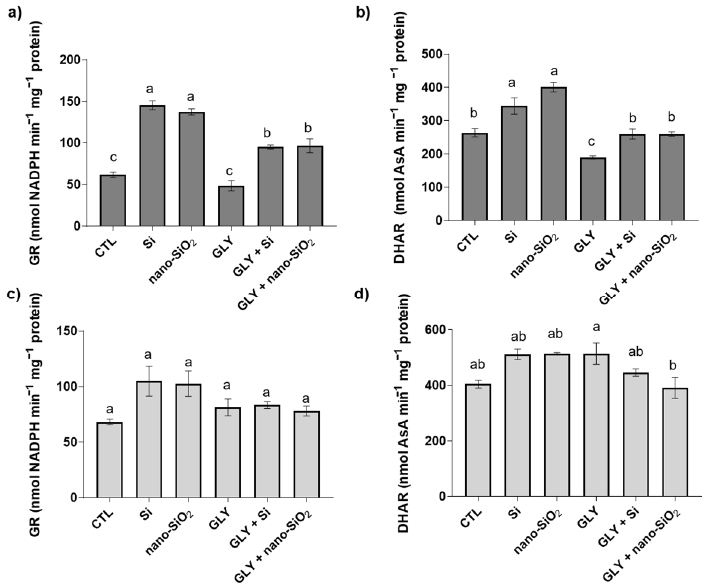
Figure 7. Total activity of glutathione reductase (GR; a , c ); dehydroascorbate reductase (DHAR; b , d ) of S. lycopersicum plants after 4 weeks of growth. Dark and light bars represent shoots and roots, respectively. Data presented are mean ± STDEV ( n ≥ 3). Different letters (a–c) above bars indicate significant statistical differences between treatments (Tukey: p ≤ 0.05).